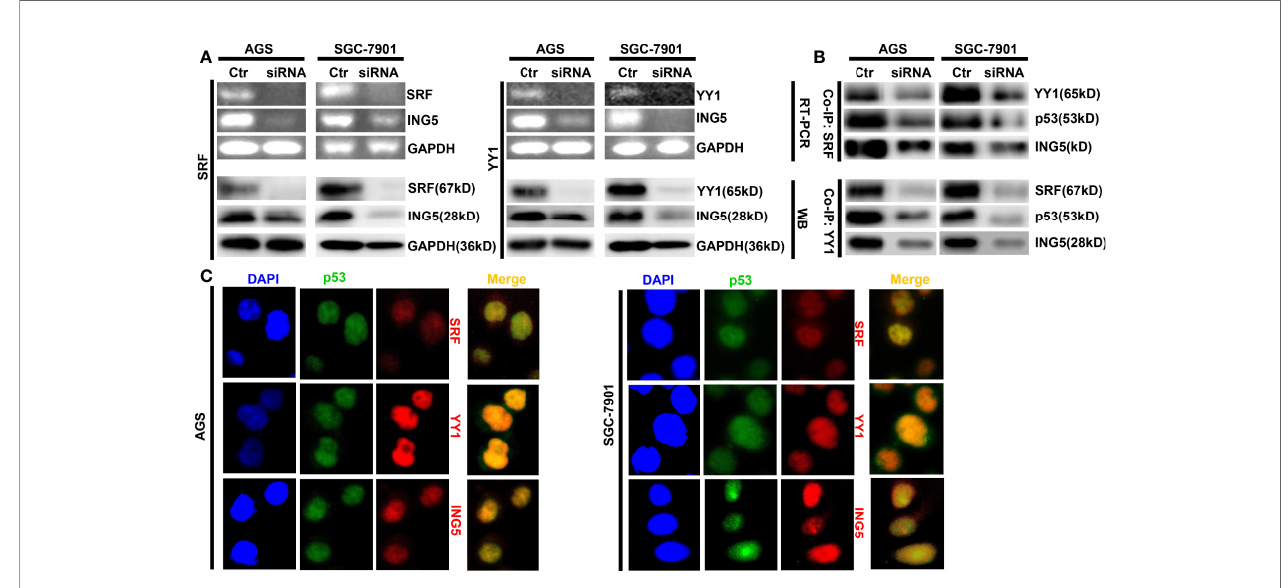
FIGURE 2 | The promoting effects of both SRF and YY1 proteins on ING5 expression The results of RT-PCR and Western blot revealed the successful silencing of SRF and YY1 expression in AGS and SGC-7901 cells, which showed low ING5 mRNA and protein expression (A) . Co-IP was performed to explore whether SRF bind to YY1, p53 and ING5 or YY1 to SRF, p53 and ING5 in both gastric cancer cells, treated with SFR or YY1 siRNA (B) . Double immuno fl uorescence was carried out to observe the co-localization of YY1, SRF or ING5, and p53 in gastric cancer cells (C) . Ctr, control; RT-PCR, reverse-transcriptional polymerase chain reaction; WB, western blot; Co-IP,